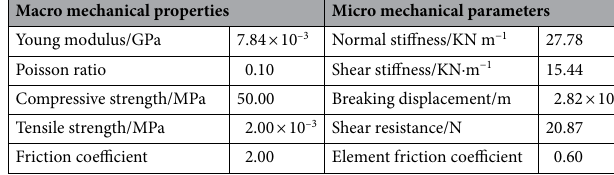
Table2. Macro and micro mechanical properties of the rubber